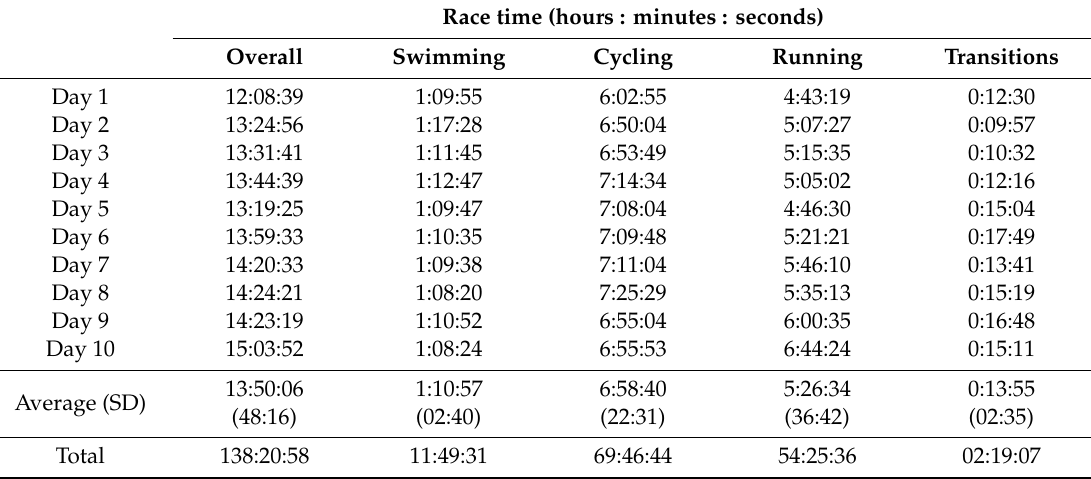
Table 2. Race time in a Deca Iron